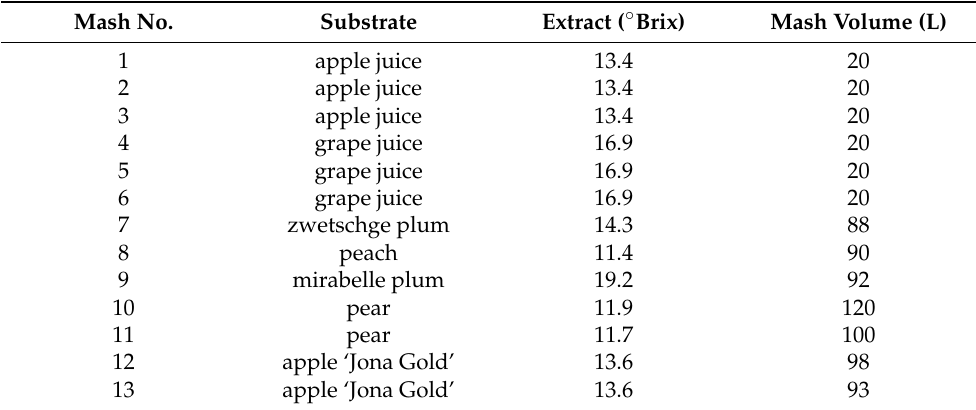
Table 1. Overview of substrates for mash preparation. Mash